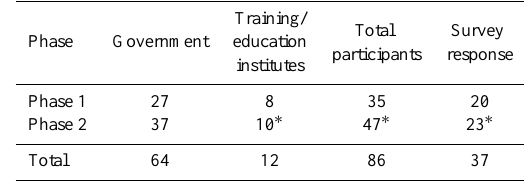
Table 3. Mid-level professionals participating in Phase 1 and 2 of the MRC-FMMP Capacity Building